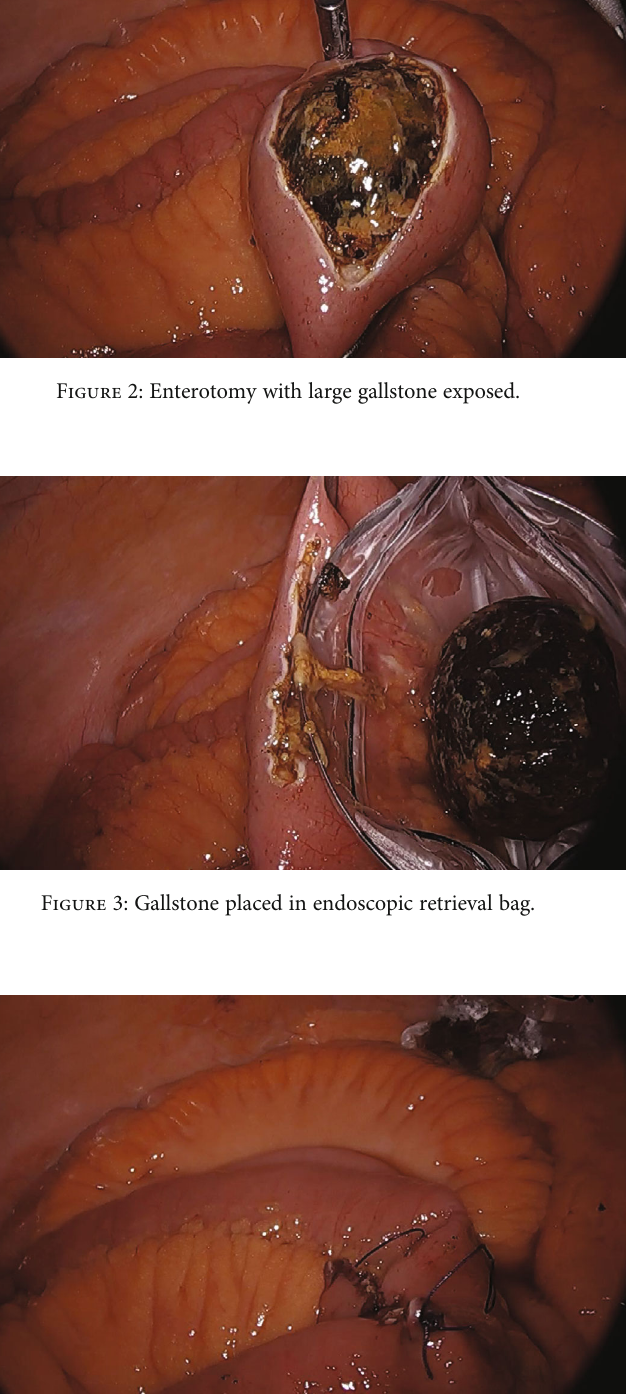
Figure 4: Transverse closure of longitudinal